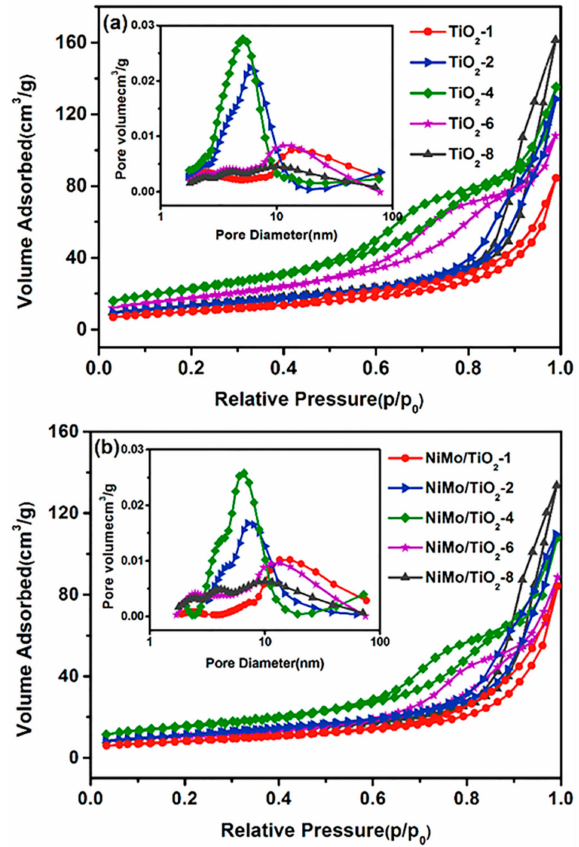
Figure 3. Nitrogen adsorption–desorption isotherms and pore size distributions of ( a ) supports and ( b )